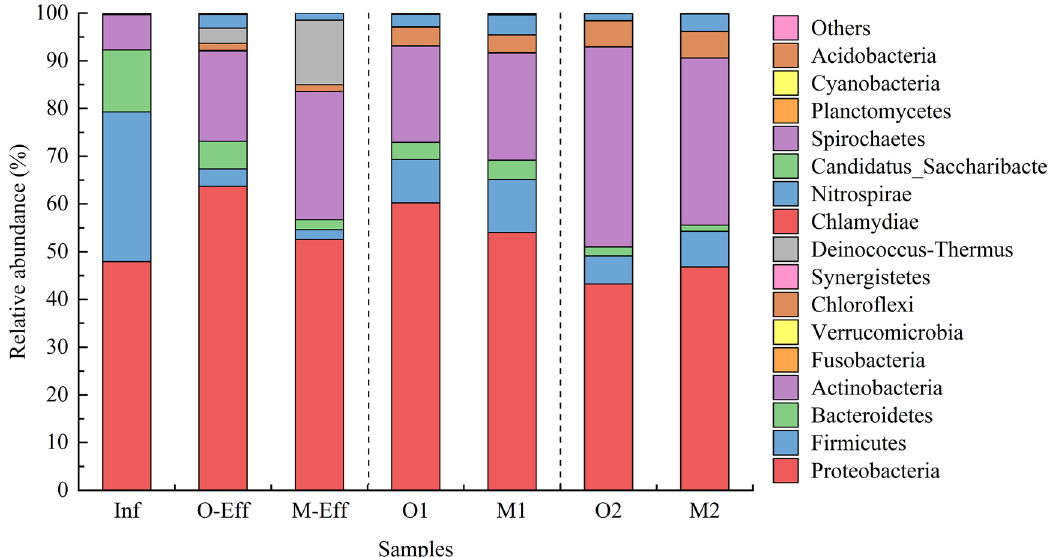
Figure 1. Community structure at the phylum level in the OD and MBR systems.